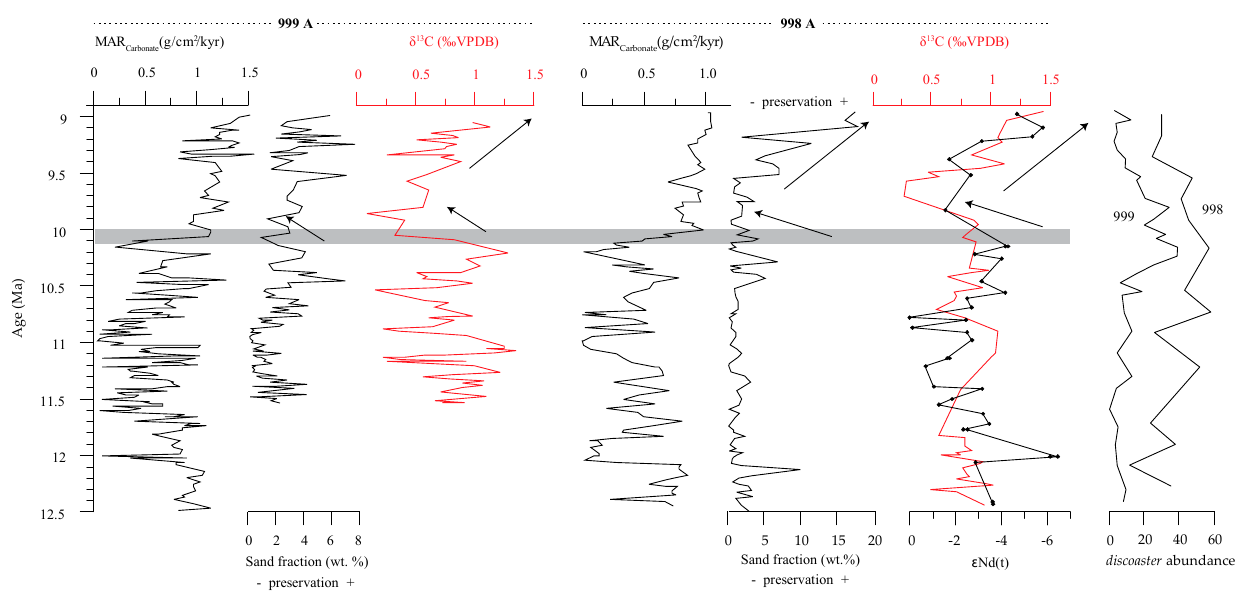
Figure 5. Caribbean records show that the preservation is increasing after 9.5 Ma. However, this development is in conflict with already enhanced MAR.